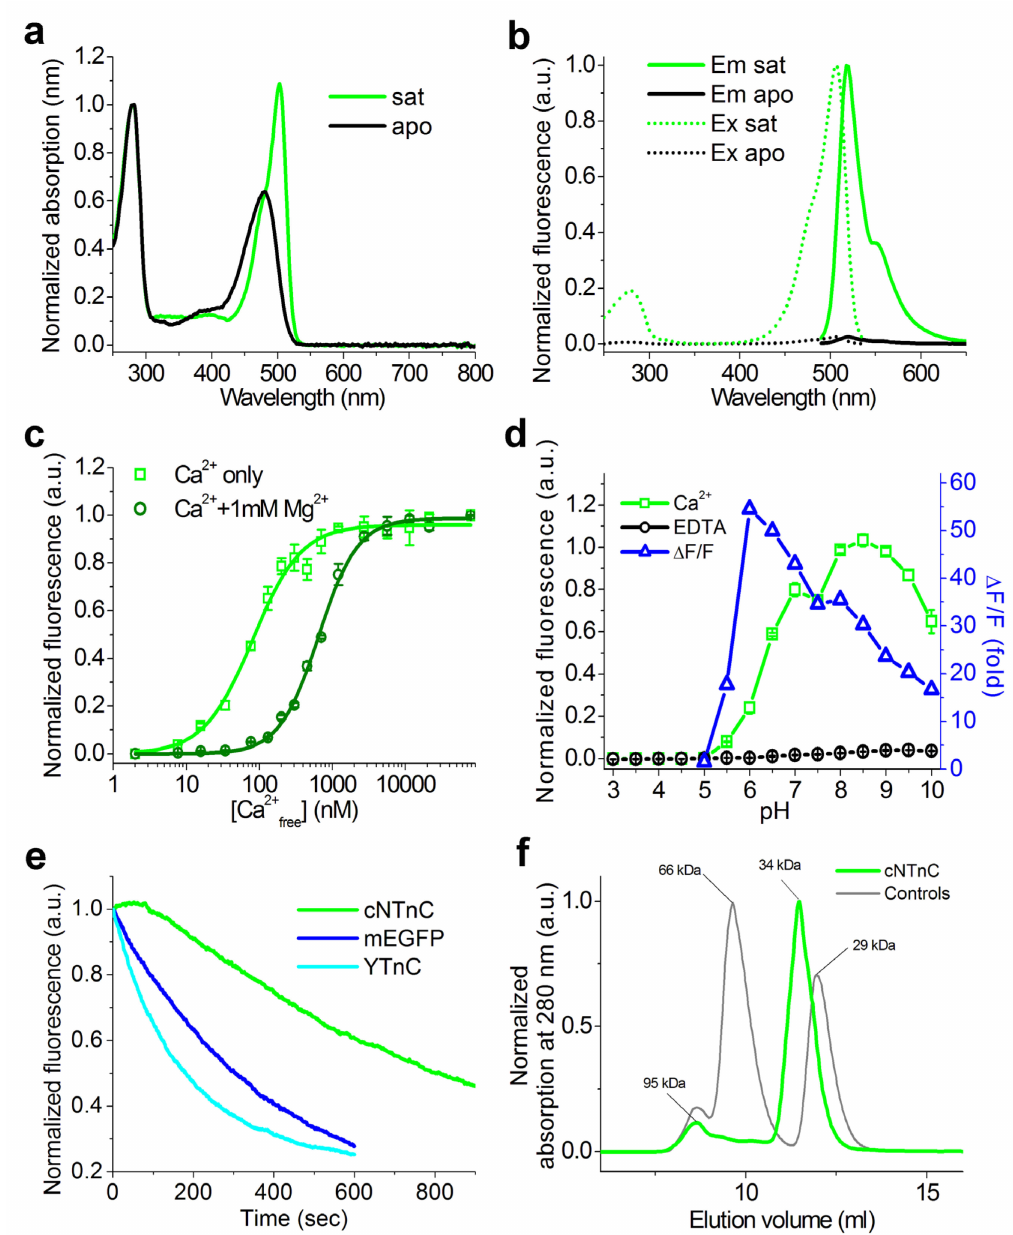
Figure 5. In vitro properties of purified cNTnC protein. ( a ) Absorbance spectra of cNTnC in Ca 2+ -free (apo) and Ca 2+ -bound (sat) states. ( b ) Excitation and emission spectra of cNTnC in Ca 2+ -free and Ca 2+ -bound states. ( c ) Ca 2+ titration curves of cNTnC in the absence or presence of 1 mM MgCl 2 . ( d ) Intensity and dynamic range of cNTnC as a function of pH. The ∆ F/F fluorescence response (fold) at each pH value was determined as the ratio of cNTnC fluorescence intensity in the absence of Ca 2+ to that in the presence of Ca 2+ . ( e ) Photobleaching curves for cNTnC and YTnC in the Ca 2+ -bound states and for mEGFP. ( f ) Fast protein liquid chromatography of cNTnC. cNTnC was eluted in 20 mM Tris-HCl (pH 7.80) and 200 mM NaCl buffer. The molecular weight of cNTnC was calculated from a linear regression of the dependence of the logarithm of the control molecular weights vs. elution volume (Figure S10). Error represents the standard error of the estimate for the average of three